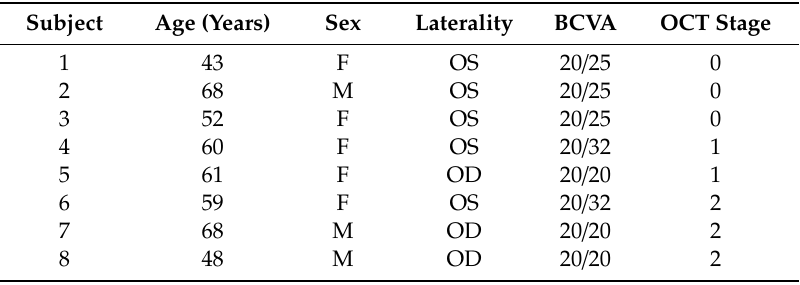
Table 1. Subject demographics, clinical characteristics, and clinical staging.